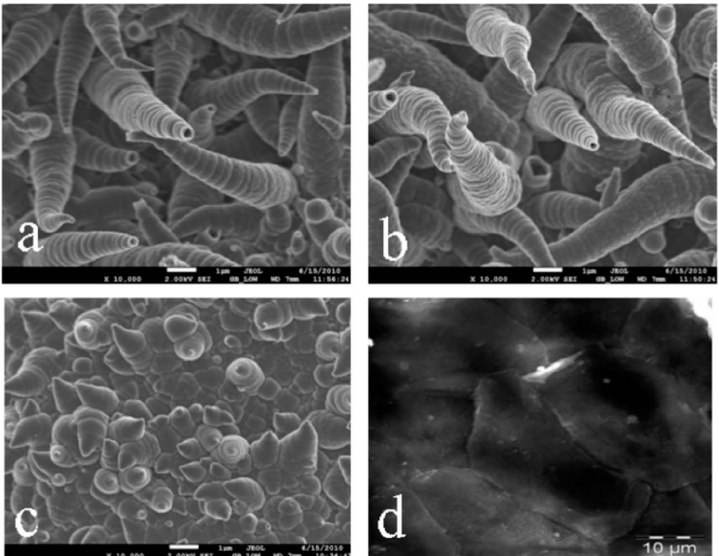
Figure 3. SEM images of ( a , b ) electrochemically synthesized G2PPI-co-PPy ( × 10,000), ( c ) electrochem- ically synthesized PPy on bare Pt-electrode ( × 10,000) and ( d ) functionalized dendrimer (G2PPI-2Py). Reprinted with permission from Reference [37]. Copyright 2014